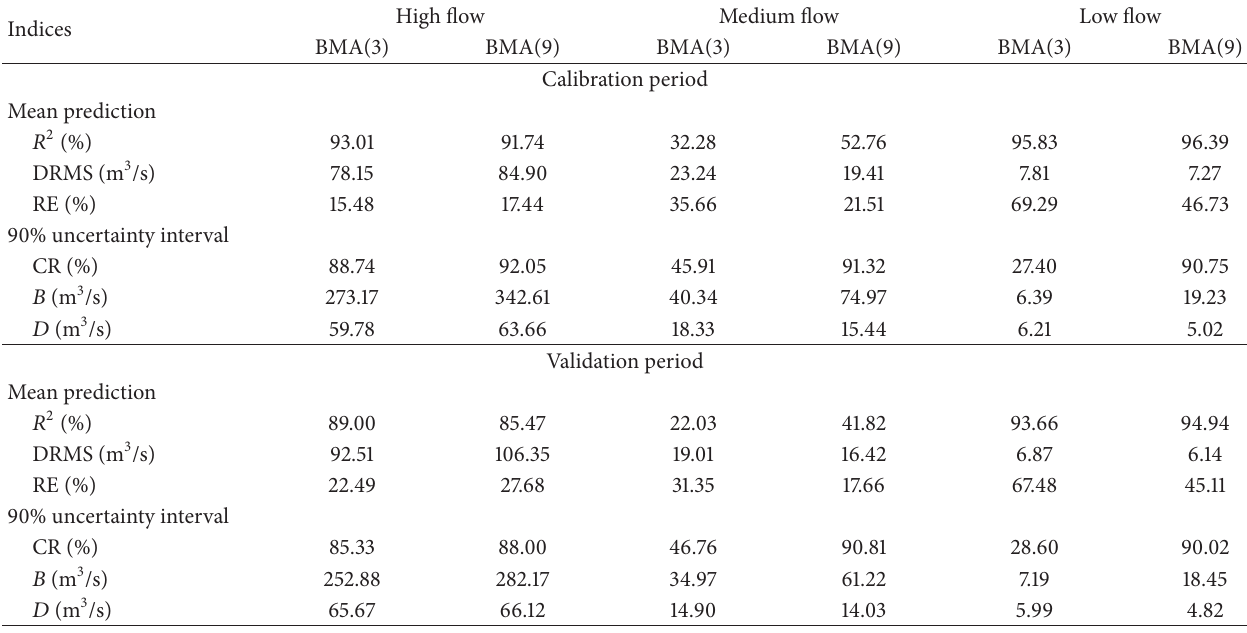
Table 4: The comparison of BMA(3) and BMA(9) in the mean prediction and 90% uncertainty interval for three flow